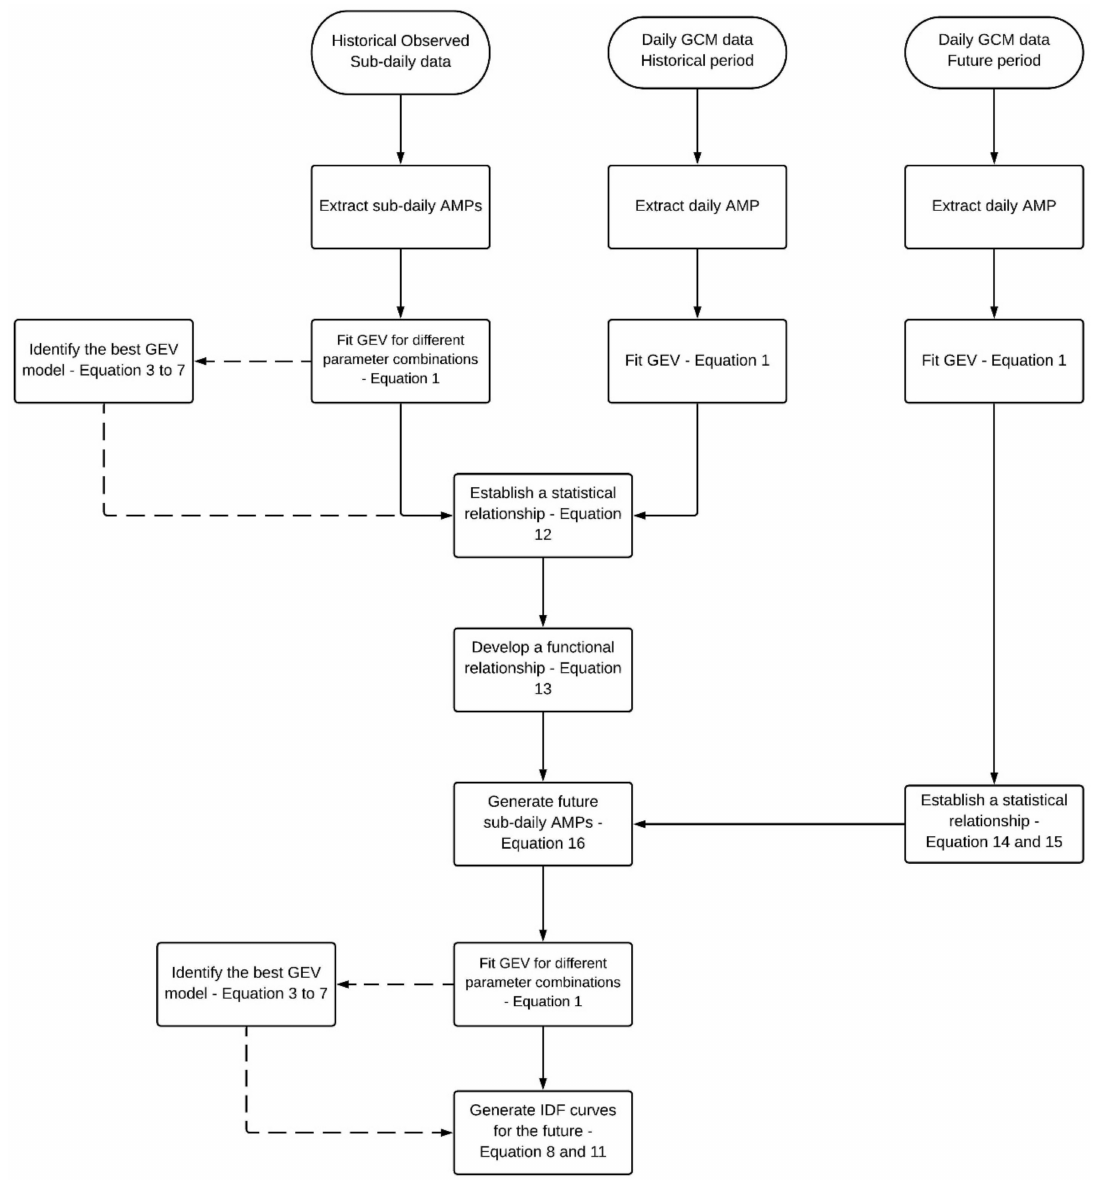
Figure 2. Framework for generating non-stationary intensity-duration-frequency (IDF) curves under climate change. Modified from